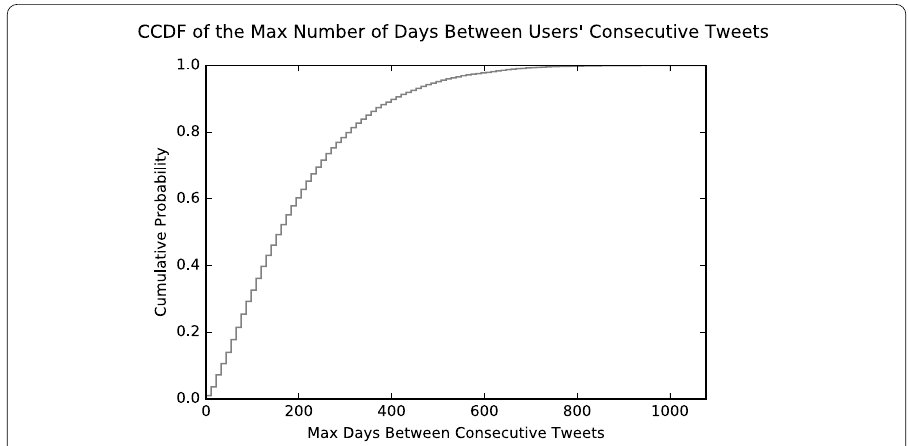
Figure 1 A CDF of the max number of days between consecutive tweets for each user. Only a small share of users have consistent tweets without at least one large gap during out time window—a criterion that